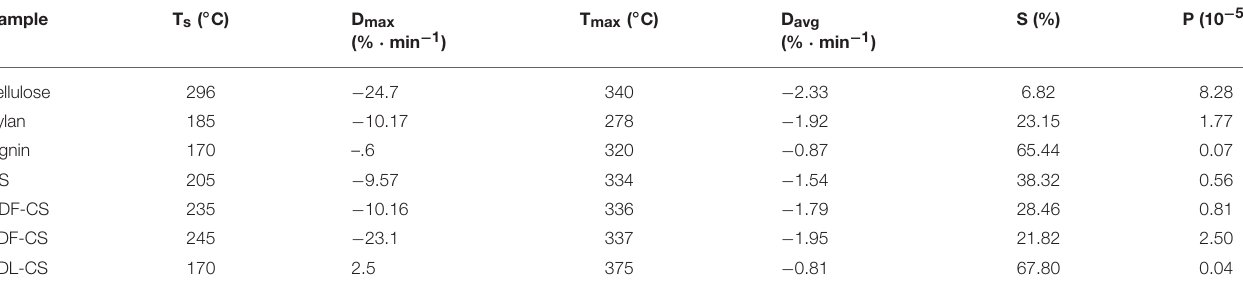
TABLE 4 | Pyrolytic parameters of three simplex model compounds (cellulose, xylan and lignin) (a,b), CS and its detergent fibers. Sample